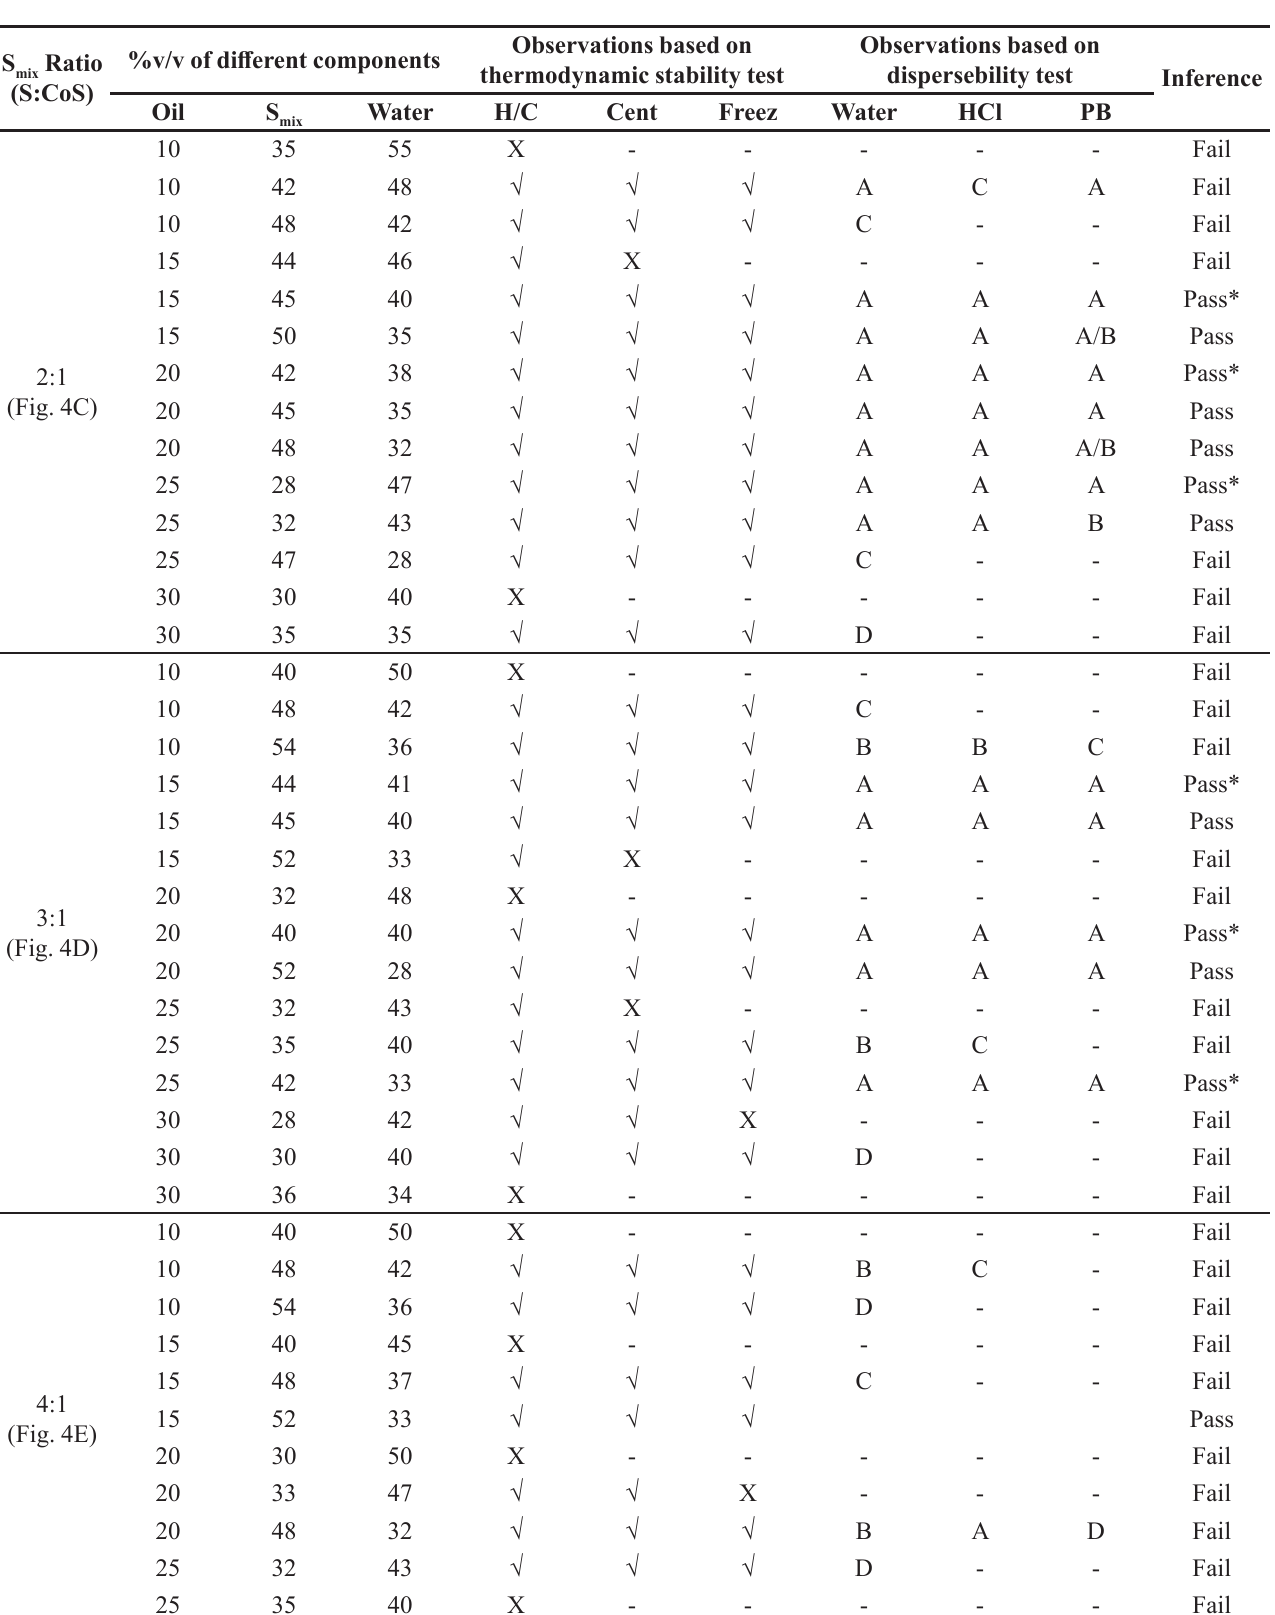
Observations based on thermodynamic stability test